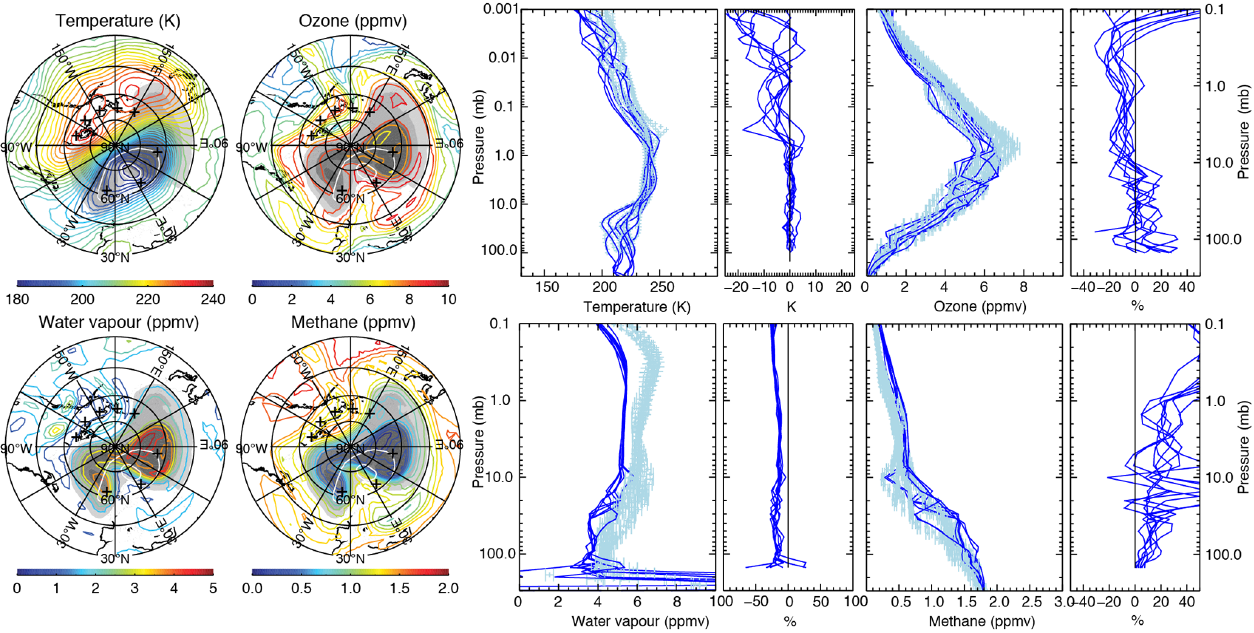
Figure 14. Same as for Fig. 11 but for 25 January 2006 in the NH. sPV values are 1, 1.2, 1.4, 2, 3 . 25 × 10 − 4 s − 1 . The locations of the ACE-FTS profiles are marked on the maps by black crosses. No OSIRIS data are available for this